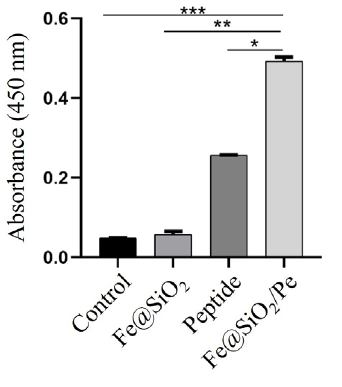
Figure 8. Room temperature, magnetic hysteresis loops of Fe@SiO and Fe@SiO /Pe. Inset: Extended hysteresis loops. 2